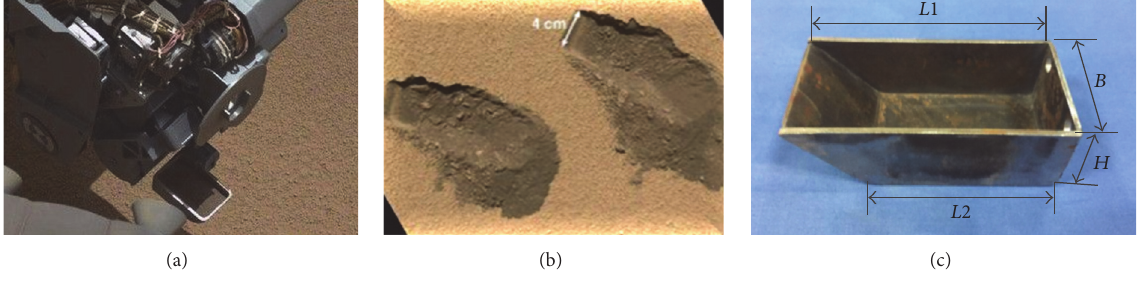
Figure 10: (a) Curiosity scoop. (b) Traces of excavation on Mars. (c) Prototype scoop.